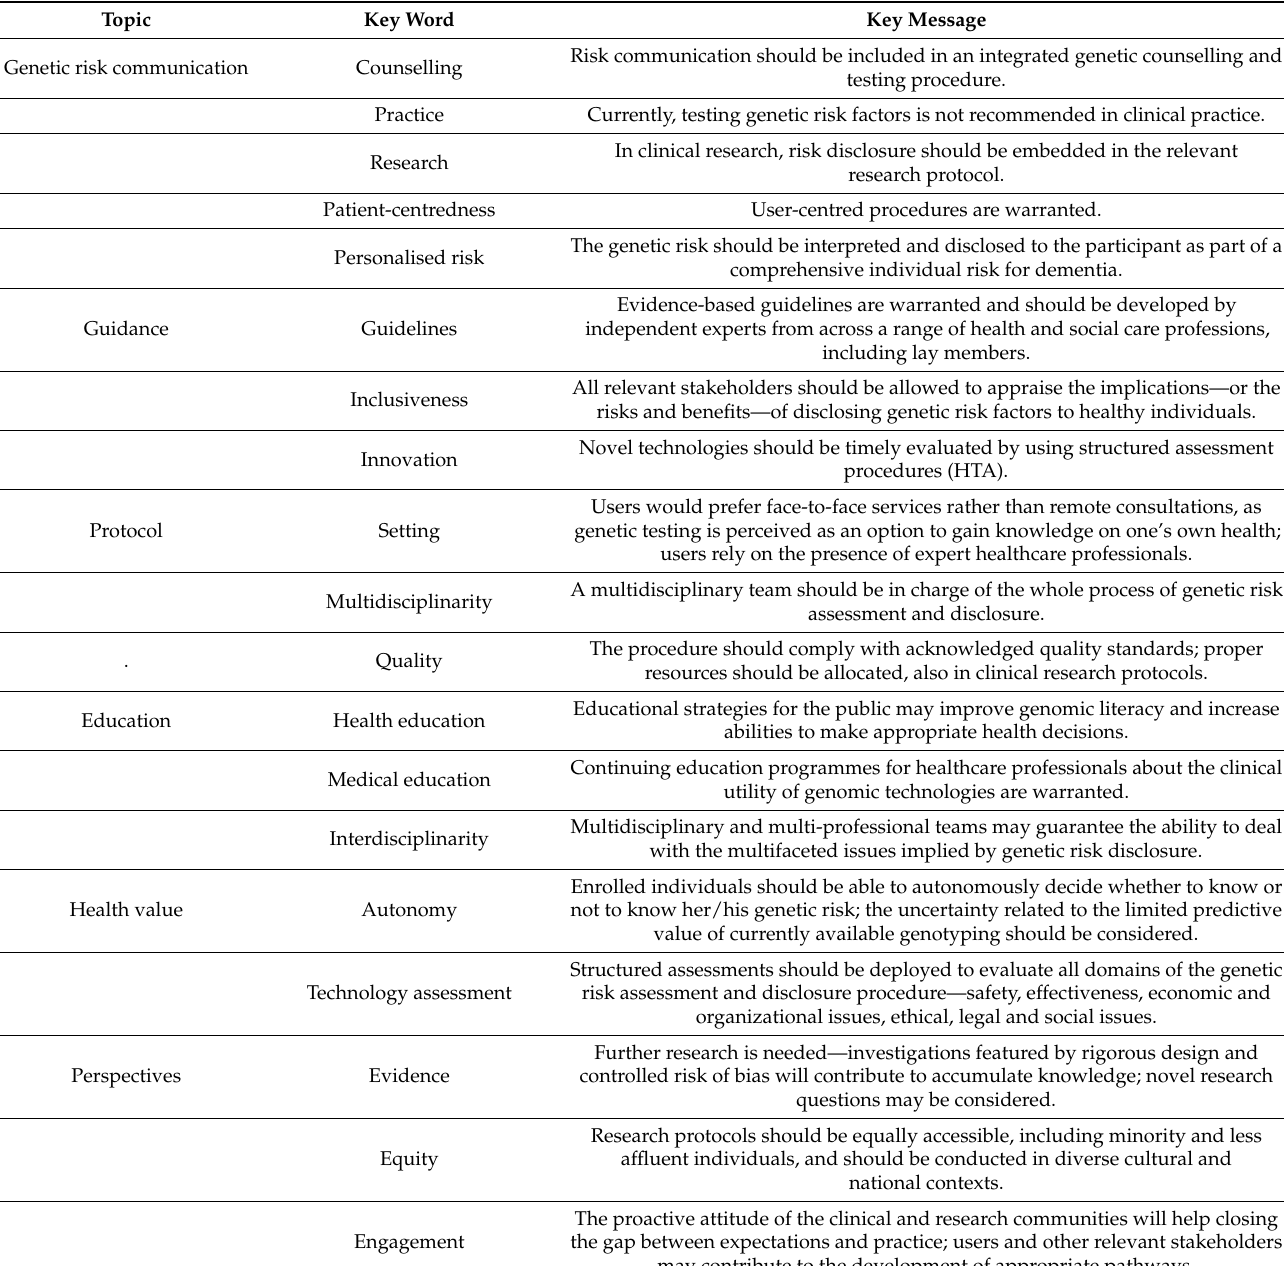
Table 2. Disclosure of genetic risk factors for AD to cognitively healthy individuals—key messages and future